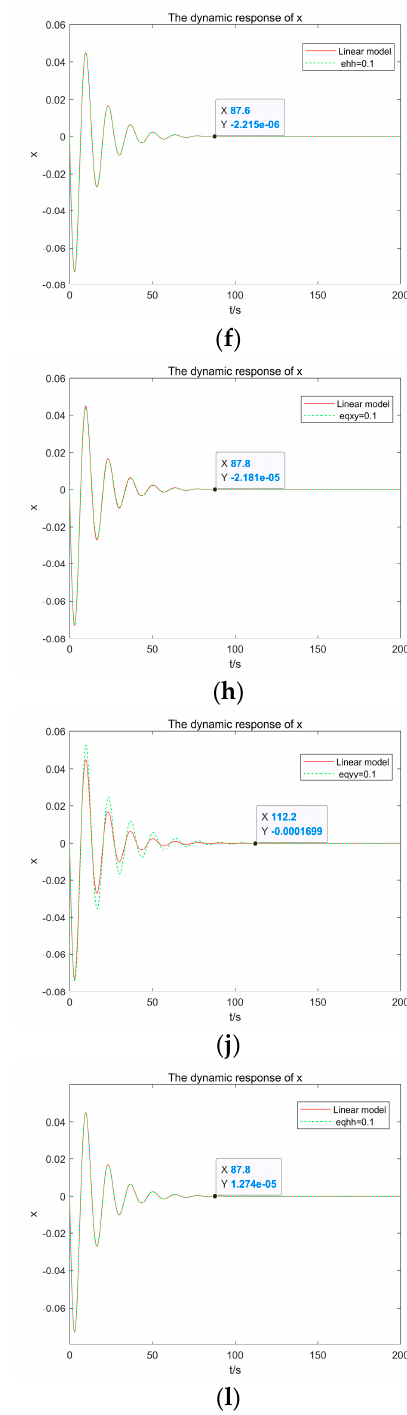
Figure 8. Time domain plot of a nonlinear model with different second derivative terms: ( a ) e